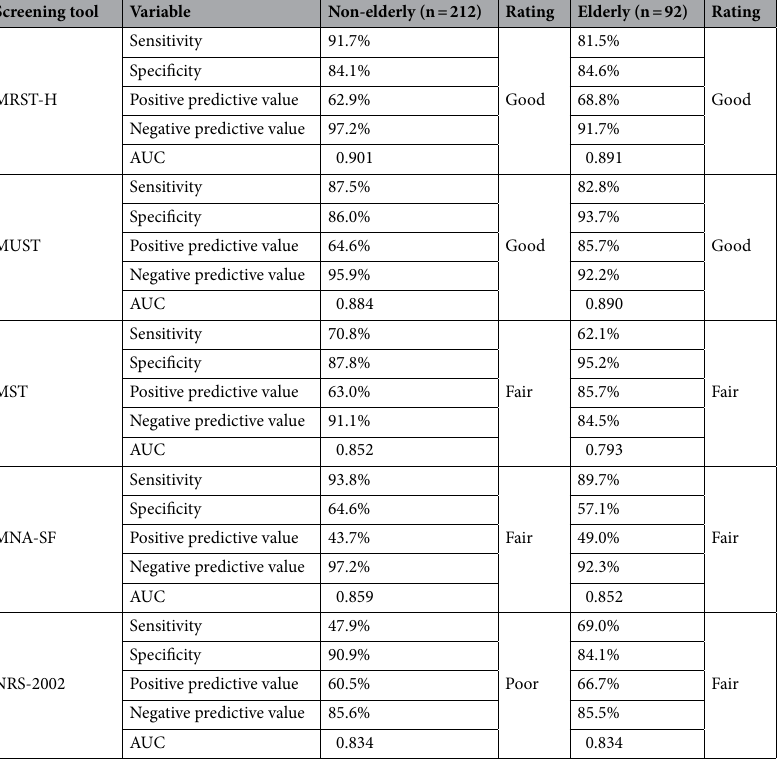
Table 6. Comparison of sensitivity, specificity, positive predictive value, negative predictive value, and the area under the curve for different screening tools against GLIM-DCM. MRST-H Malnutrition Risk Screening Tool-Hospital, MNA-SF Mini Nutritional Assessment-Short Form, MST Malnutrition Screening Tool, MUST Malnutrition Universal Screening, NRS-2002 Nutritional Risk Screening, AUC Area under the curve, GLIM- DCM Diagnosis criteria for malnutrition by the Global Leadership Initiative on Malnutrition 9 .